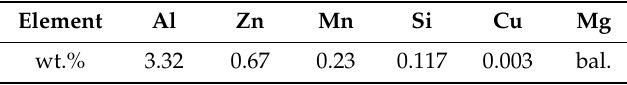
Table 1. Chemical composition of AZ31 magnesium alloy.